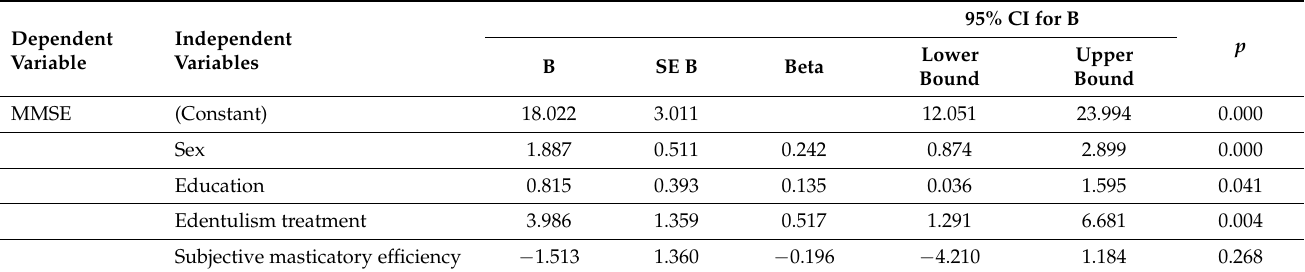
Figure 1. Linear regression plot showing a positive correlation between MMSE scores and edentu- lous treatments. Table 4. Linear regression analysis: association between MMSE score, sex, education, dentures, and subjective masticatory efficiency.